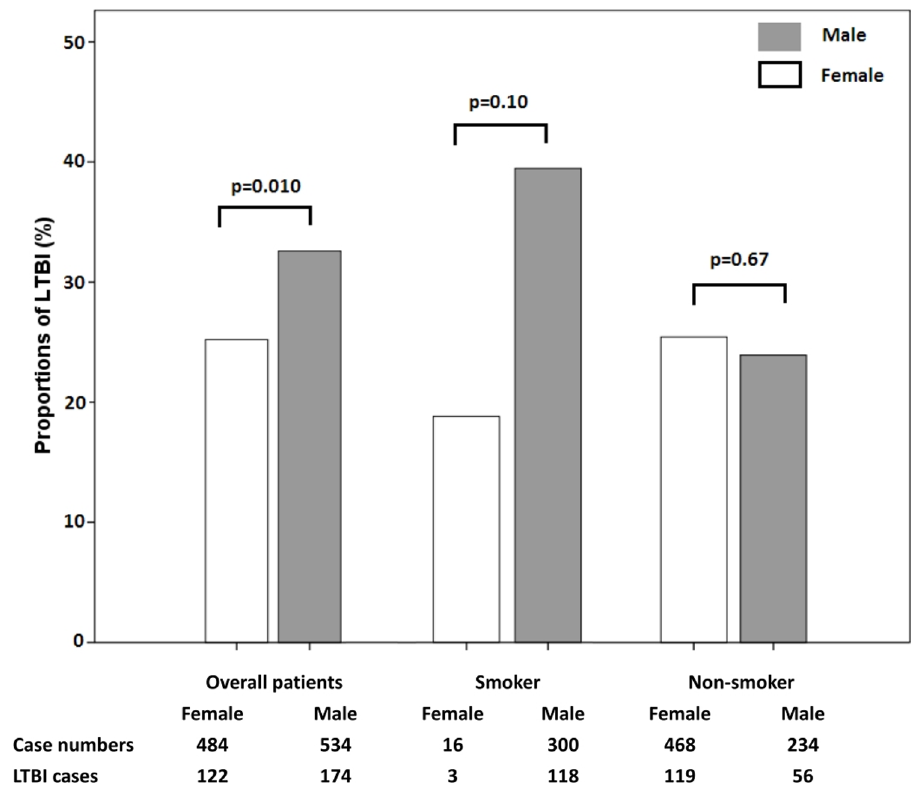
Figure 3. Proportions of LTBI between sexes in smokers and non-smokers.